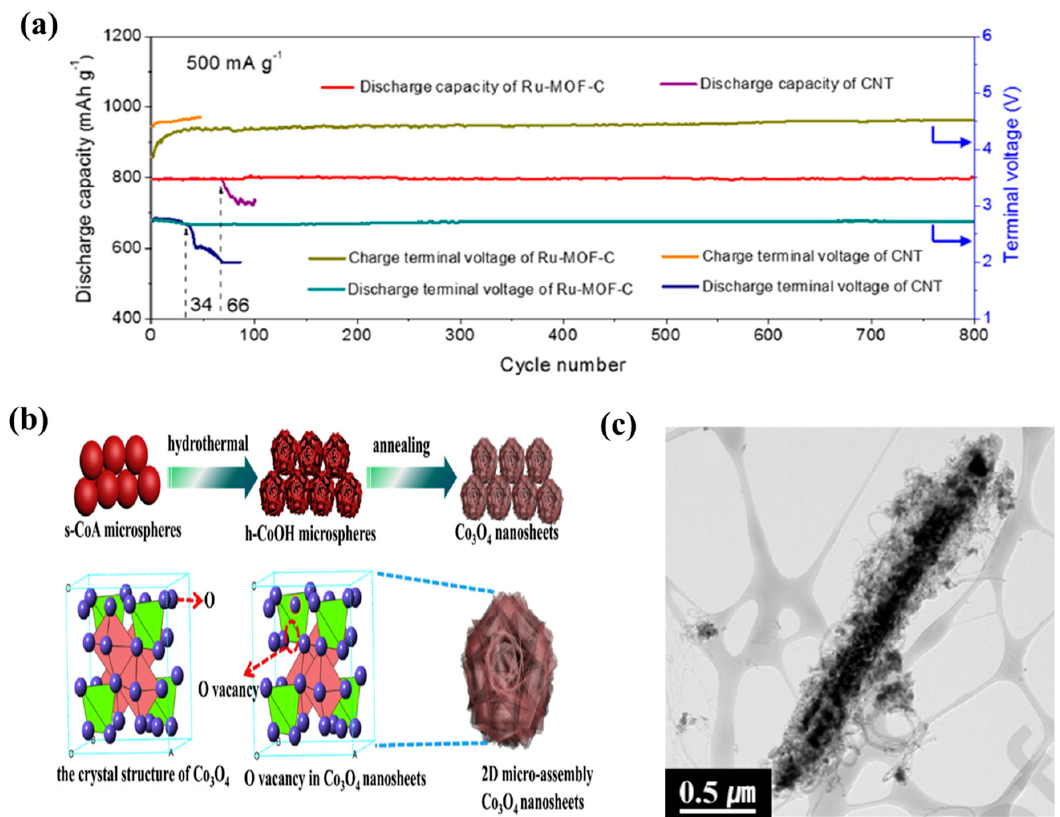
Figure 8. ( a ) The discharge capacities of the LOBs with Ru-MOF − C and CNT as the catalyst at a current density of 500 mA/g [107]. ( b ) The schematic representation of the synthetic procedure for 2D